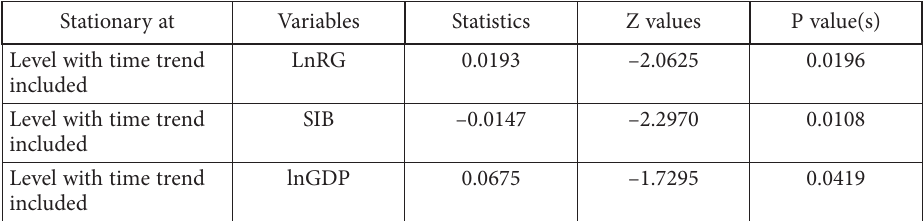
Table 5. Harris-Tzavalis unit-roots test (source: author’s calculation STATA program, 2021) Stationary at